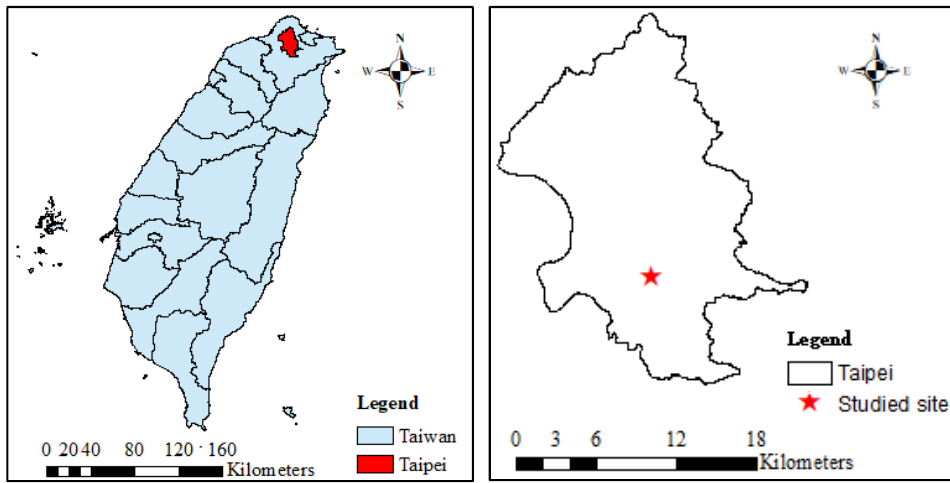
Figure 2. Location of the study site in Taipei city. The left-hand image shows the location of the city, and that on the right shows the study area.